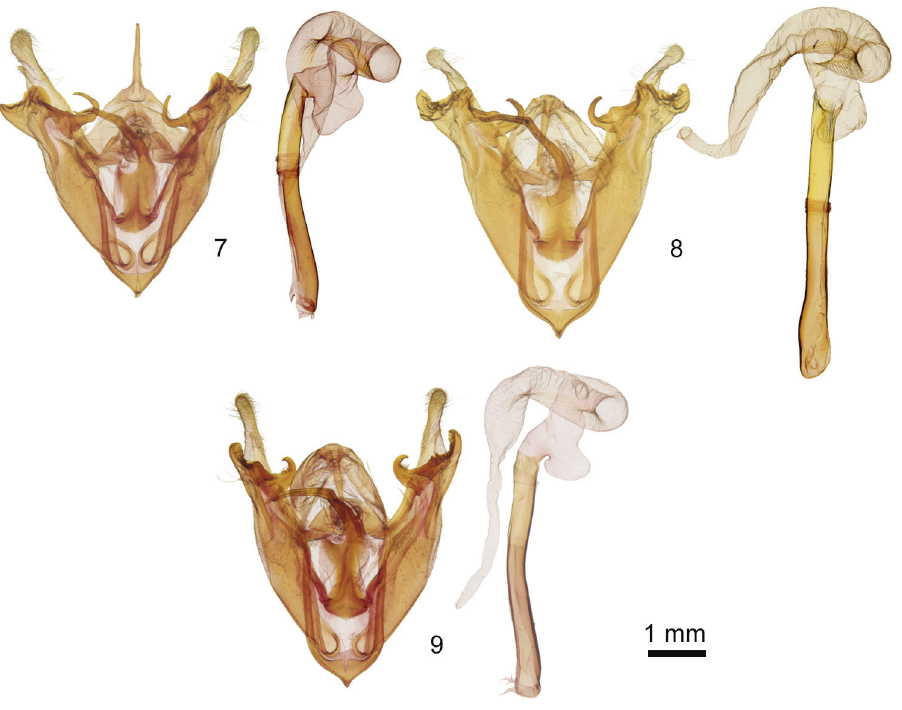
Figures 7–9. Rhabdorthodes male genitalia, valves and phalluses with everted vesicas 7 R. pattersoni 8 R. durango 9 R. petersoni . tered off-white on second and third segments, increasing toward tip. Frons scales gray brown; dorsal head scales white tipped gray-brown. Thorax. Dorsal scales long, white tipped gray-brown; appearing uniform dull gray- brown to dark brown. Wings : Forewing length 13.0–13.5 mm (males); 13.5 mm (fe- males); scales gray-brown, scattered white tipped gray-brown, appearing uniform gray- brown to dark brown; costa spots luteous gray; basal, antemedial, and postmedial lines double, black and dark gray-brown, filling ground and slightly lighter gray; basal line uneven, indistinct; antemedial line slightly irregular, pointed basad on veins; medial line slightly darker than ground, angled distad from mid costa to reniform stigma, thence basad to posterior margin; postmedial line indistinct, evident mostly as black inner part and pale gray filling, scalloped; subterminal line irregular off-white patch- es between veins, preceding shade faint, brown; terminal line thin, dark gray; fringe striped dark gray, base thin, pale; orbicular stigma round, often incomplete, black, lined with few pale-gray scales, center ground color; claviform stigma small, black, filled with ground color, or reduced to a spot; reniform stigma moderate size, weakly figure-8 shaped, open at posterior end, black, with adjacent luteous and pale-gray lin- ing strongest at medial and lateral sides, center ground color. Hindwing: Dorsum